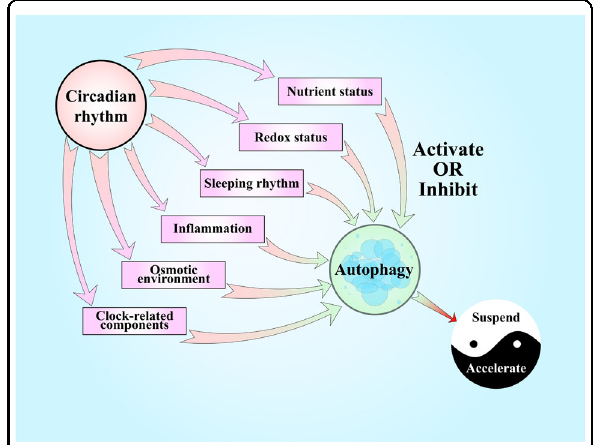
Fig. 3 The link between autophagy and the circadian rhythm in the regulation of intervertebral disc degeneration. Nutrient status, redox status, sleep rhythms, in fl ammation, and the osmotic environment are common factors affecting IVDs that show circadian rhythms in normal conditions and present close connections with autophagy. The intensity and duration of these stimuli determine the consequences of autophagy, affecting IDD. Clock-related components have recently been found to play protective roles in IVDs have been shown to affect autophagy in other